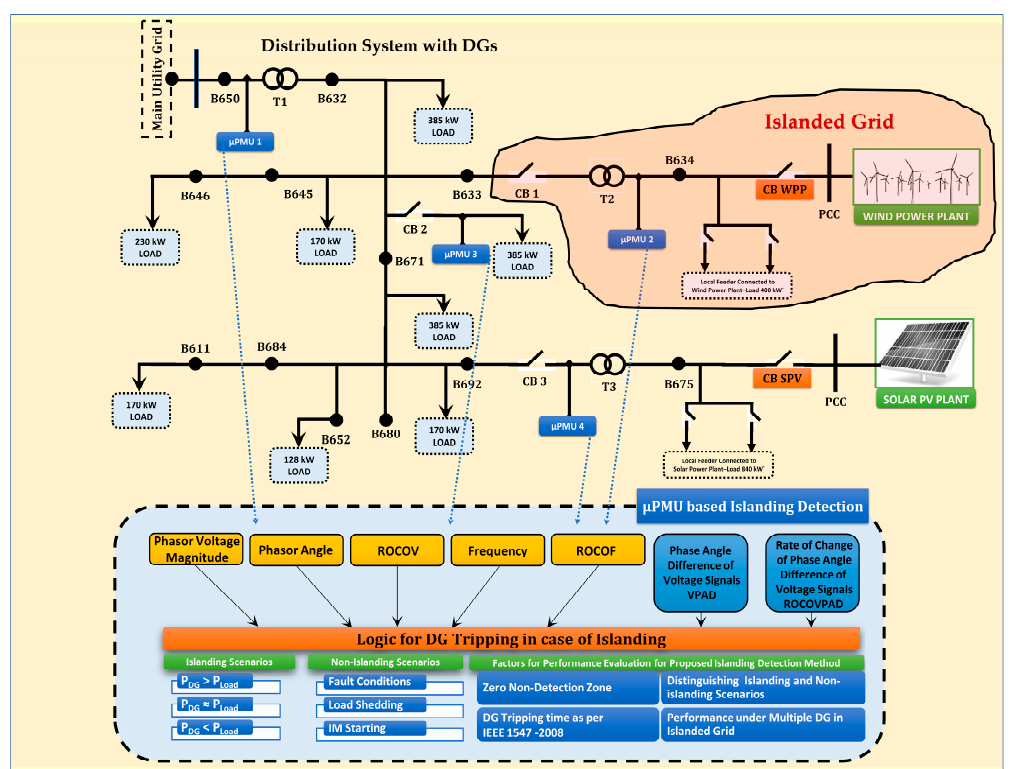
Figure 7. Graphical representation of the proposed micro-synchrophasor based